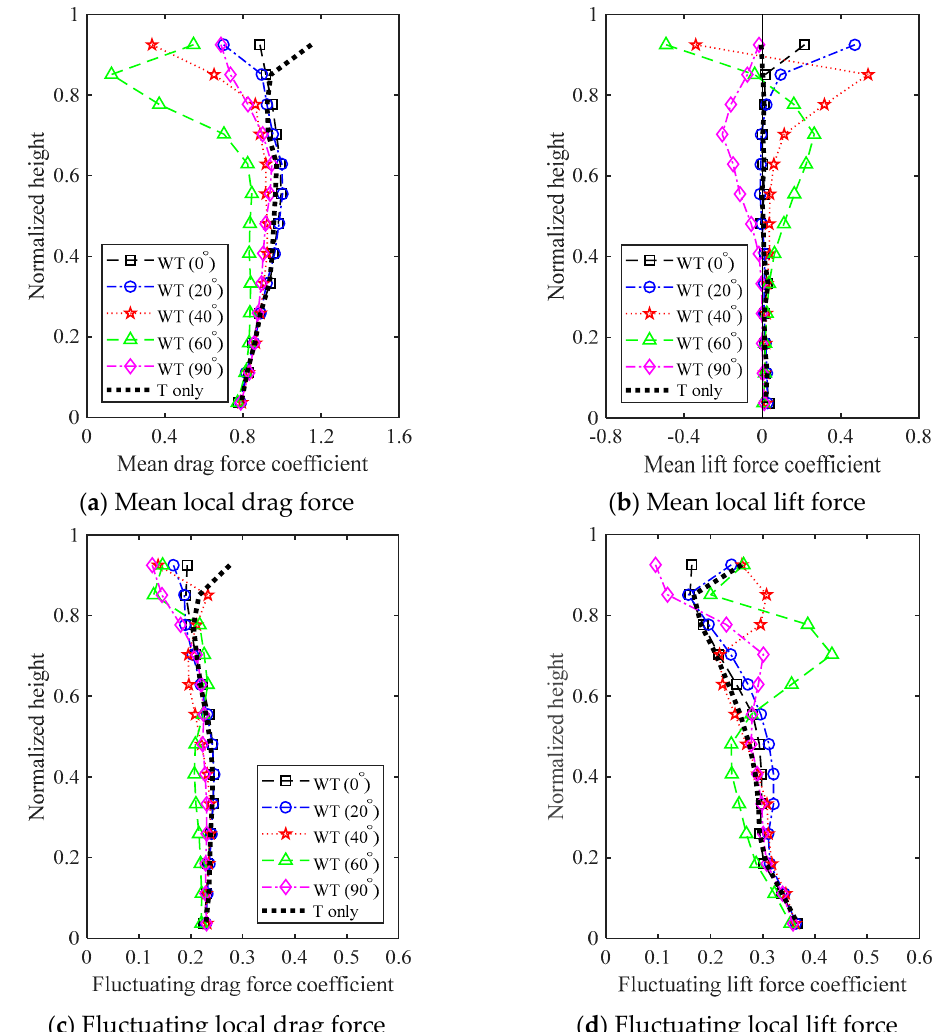
◦ and θ ◦ . pit = 90 azi = 90